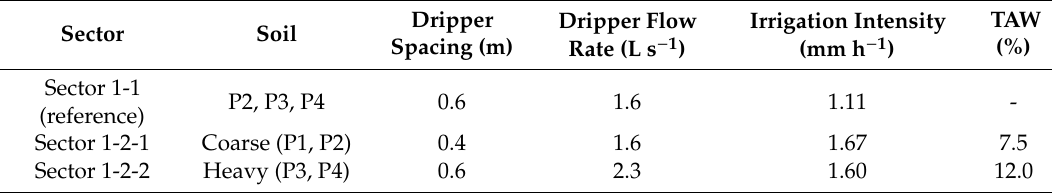
Table 3. Main features of the three irrigation sectors of the VRI system in terms of dripper spacing, flow rate and irrigation intensity; the average TAW in each sector is also reported.